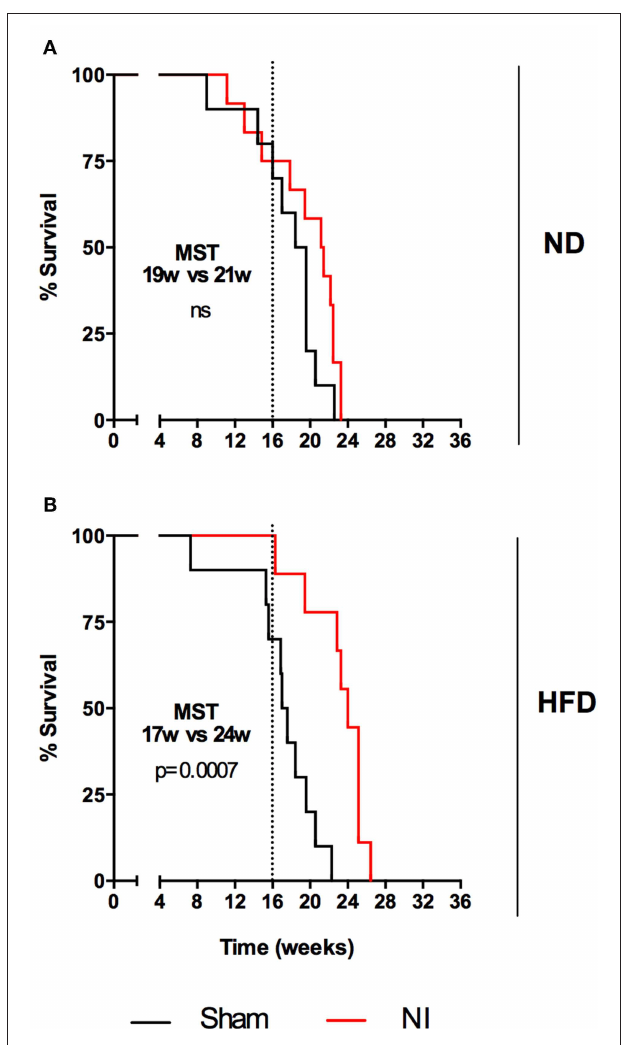
FIGURE 7 | Evolution of survival after Mtb infection for the second experiment. Each panel compares sham and NI groups: ND (A) and HFD (B) . Median survival times and p -values are indicated in each panel. Log-rank